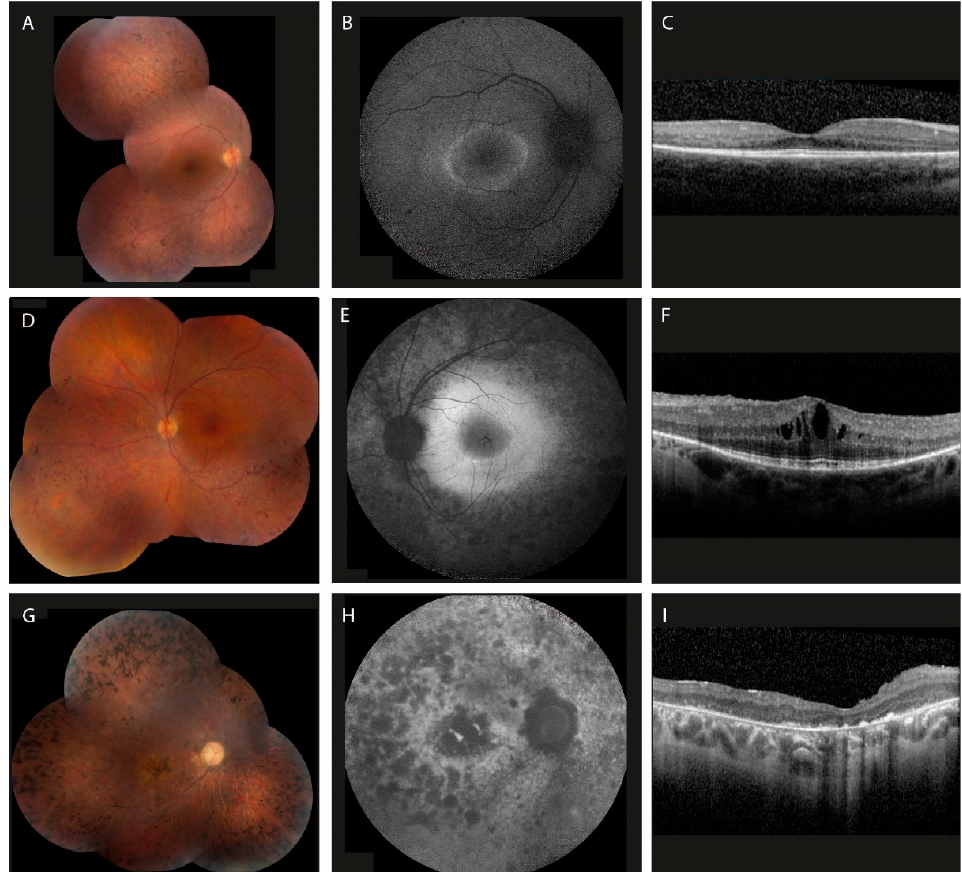
Figure 4. Multimodal imaging in three patients with retinitis pigmentosa (RP). ( A – C ): Multimodal imaging in a patient with RP caused by a variant in the RHO gene showing the clinical hallmarks of RP, including attenuated vessels and bone-spicule-like hyperpigmentation in the (mid)peripheral retina ( A ). On autofluorescence imaging, a small hyperfluorescent ring is observed in the macula ( B ). Spectral-domain optical coherence imaging shows a relatively intact central retina with loss